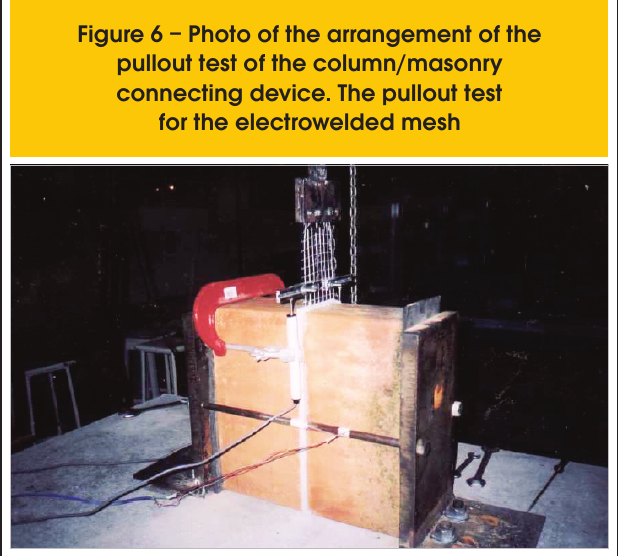
Figure 6 – Photo of the arrangement of the pullout test of the